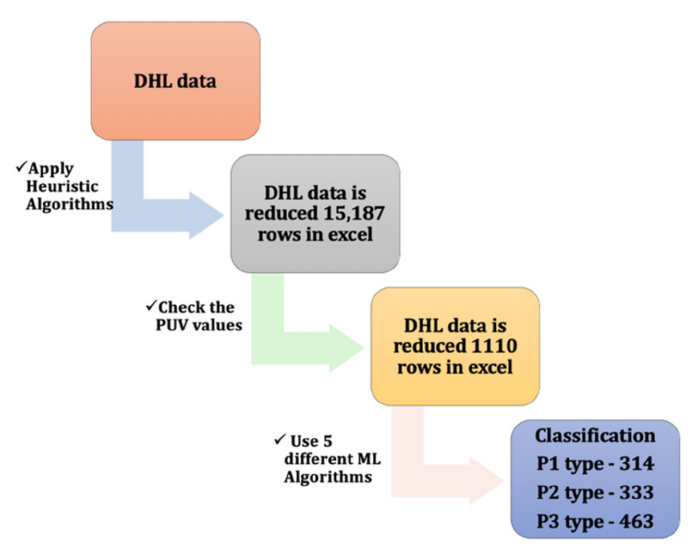
Figure 1. Flow chart of the proposed